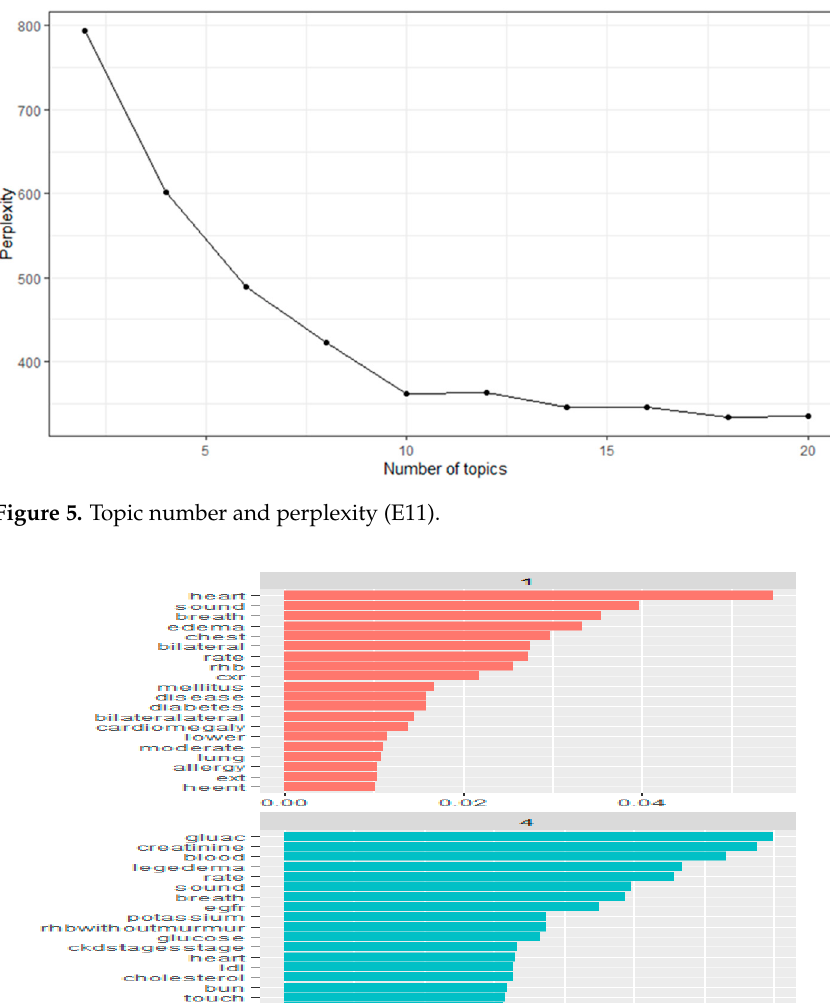
Figure 6. Word frequency distribution of 20 words in six topics (E11 Topics 1 and 4).